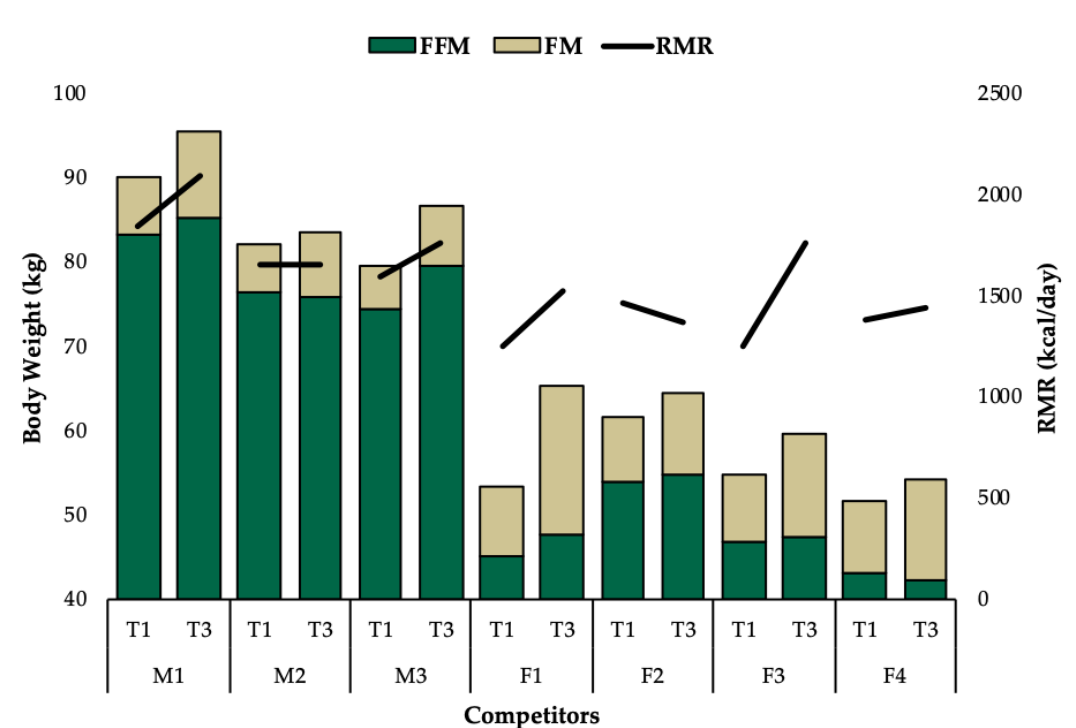
Figure 4. Individual responses for change in body weight and RMR from T1 to T3.